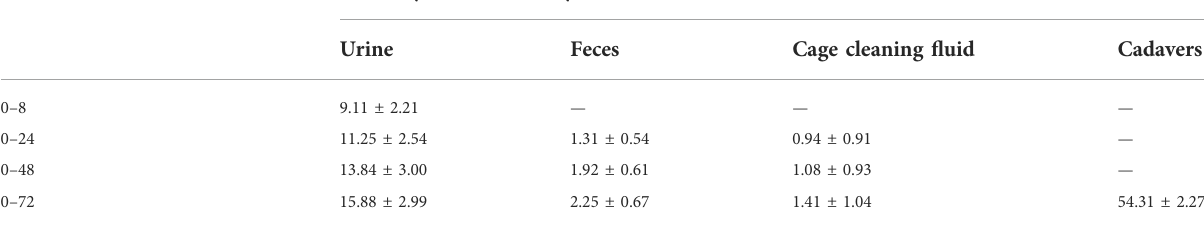
TABLE 7 The recovery of total radioactivity in the urine, feces, and cage cleaning fl uid during 0 – 72 h after intramuscular administration of [3H] BPC157 in rats. Time interval (hour)